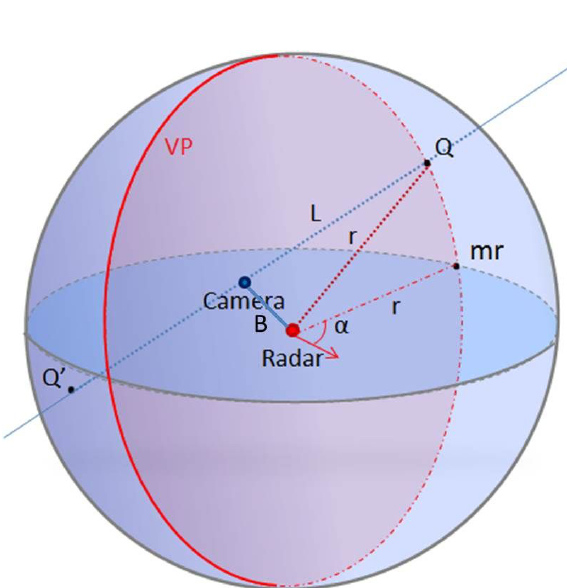
Figure 4. The 3D reconstructed point Q is the intersection of light ray L and the sphere C at α . m is the projected 2D point on the horizontal radar plane, and V P is the vertical plane r of the target at α